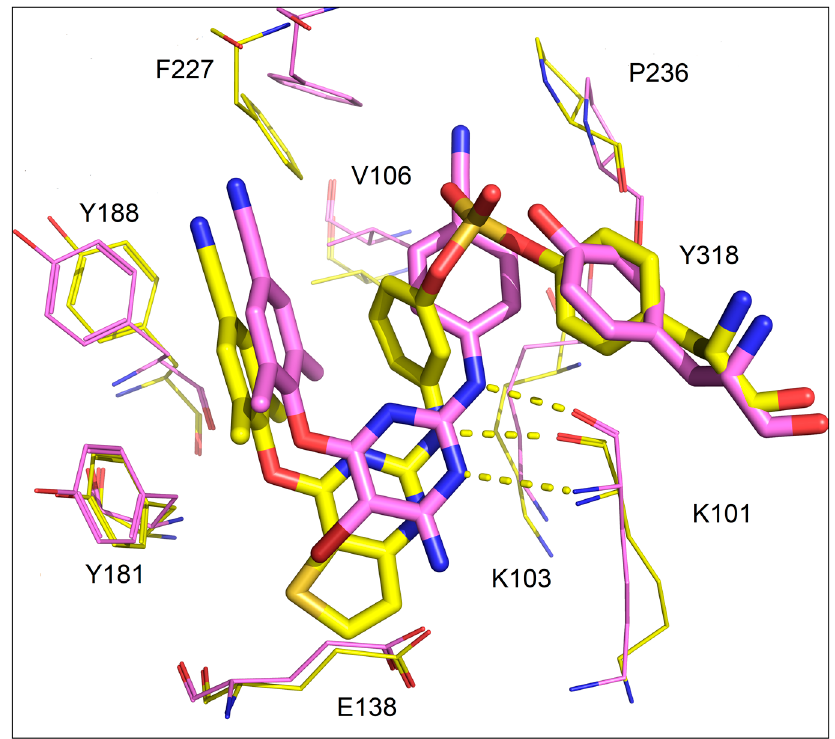
Figure 6. The superposition of ETR/HIV-1 RT co-crystal structure (purple) and the ZA-2 /HIV-1 RT predicting binding model (yellow). All hydrogen bonds are shown as yellow dotted lines. Nonpolar hydrogen atoms are not shown for clarity.